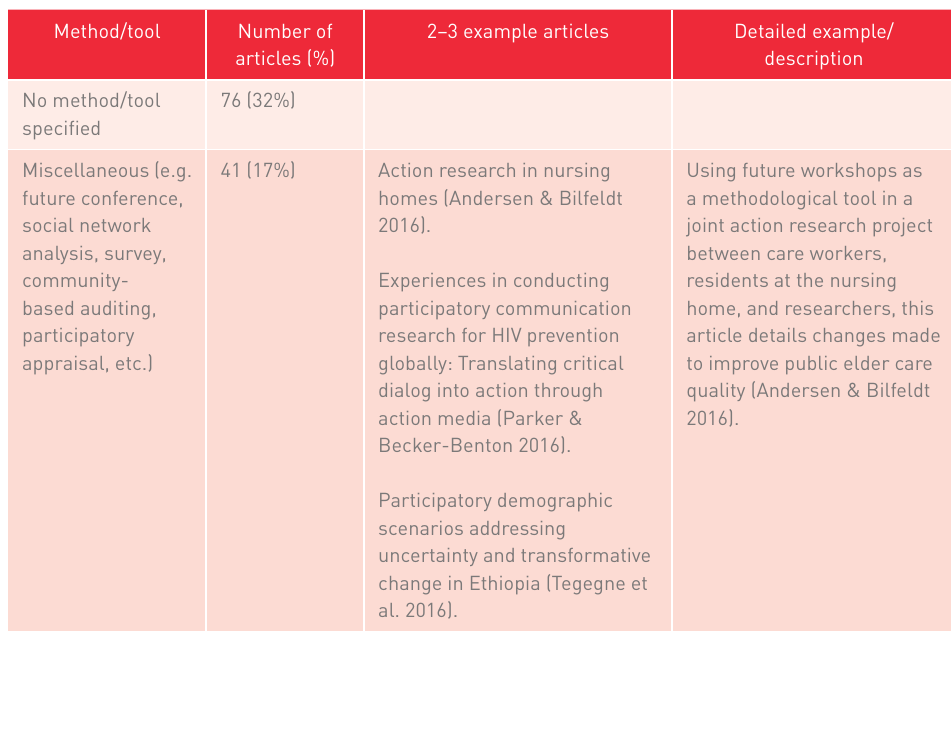
Specified methods and